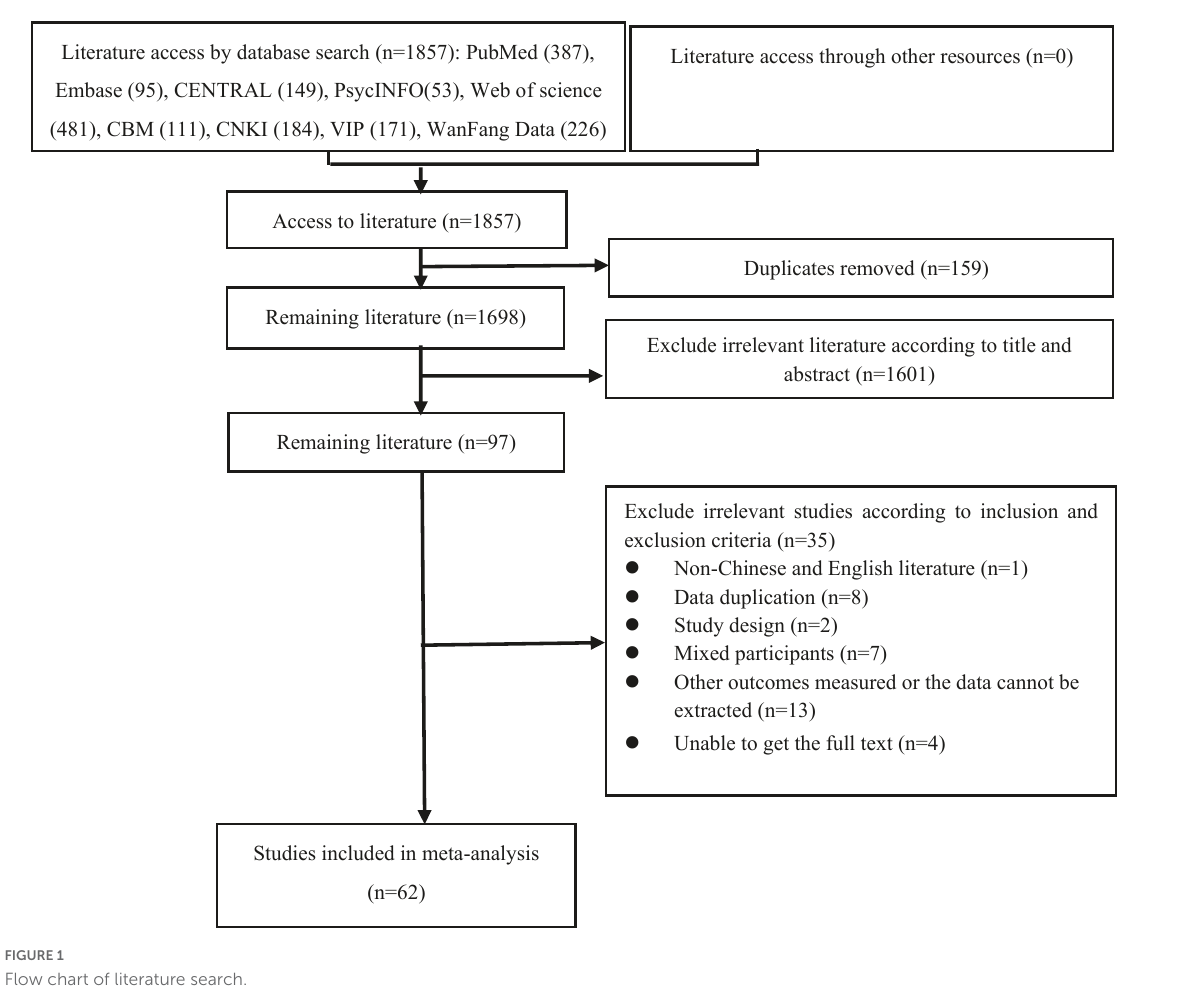
FIGURE1 Flow chart of literature search.